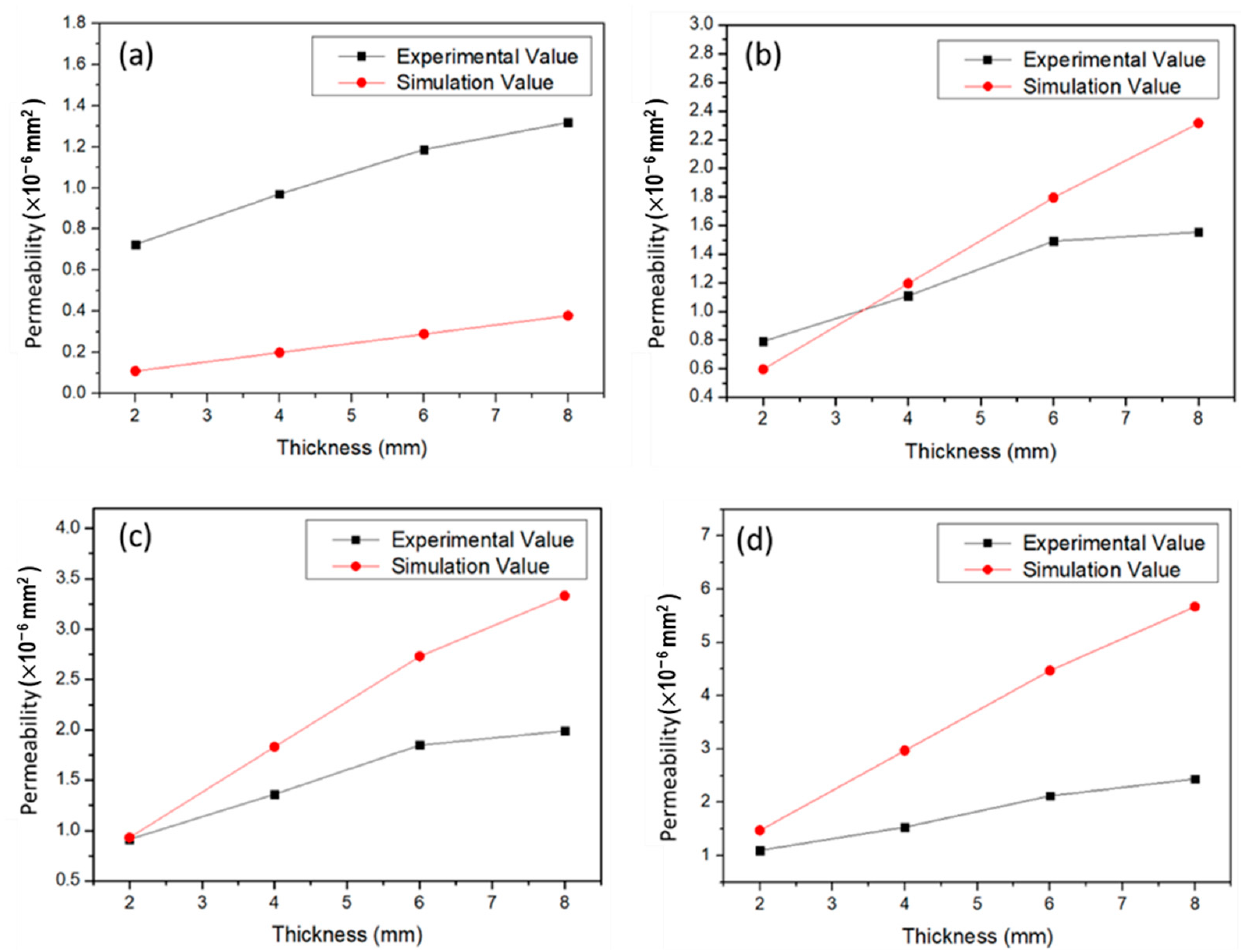
Figure 13. Comparison between permeability of cellular coupons obtained using experimental and simulation for ( a ) D3, ( b ) D5, ( c ) D7 and ( d ) D9 conditions at 0.14 MPa inlet pressure .